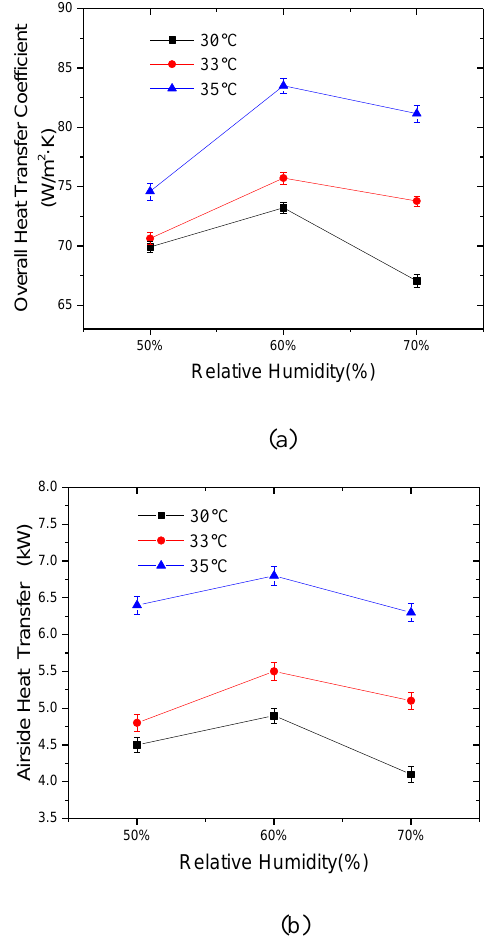
Figure 6. Variation in the overall heat transfer coe ffi cient and air-side heat transfer under di ff erent air inlet temperatures ( T a-in ) and relative humidity: ( a ) The overall heat transfer coe ffi cient under di ff erent temperatures and relative humidities; ( b ) Air-side heat transfer under di ff erent temperatures and relative